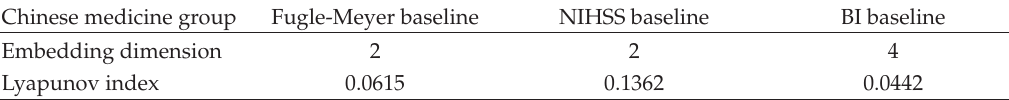
Figure 5: The time series of rehabilitation group BI baseline unit cost e ff ectiveness. Table 2: Lyapunov time series index table of Chinese medicine group for unit cost e ff ectiveness.